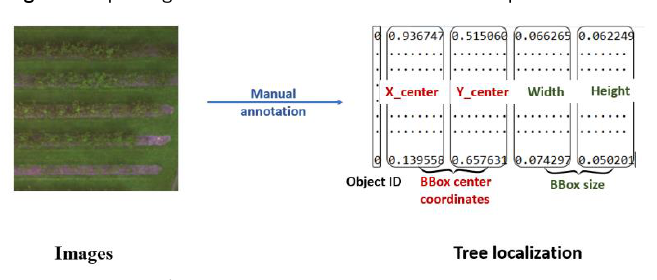
Figure 6 . Data annotation